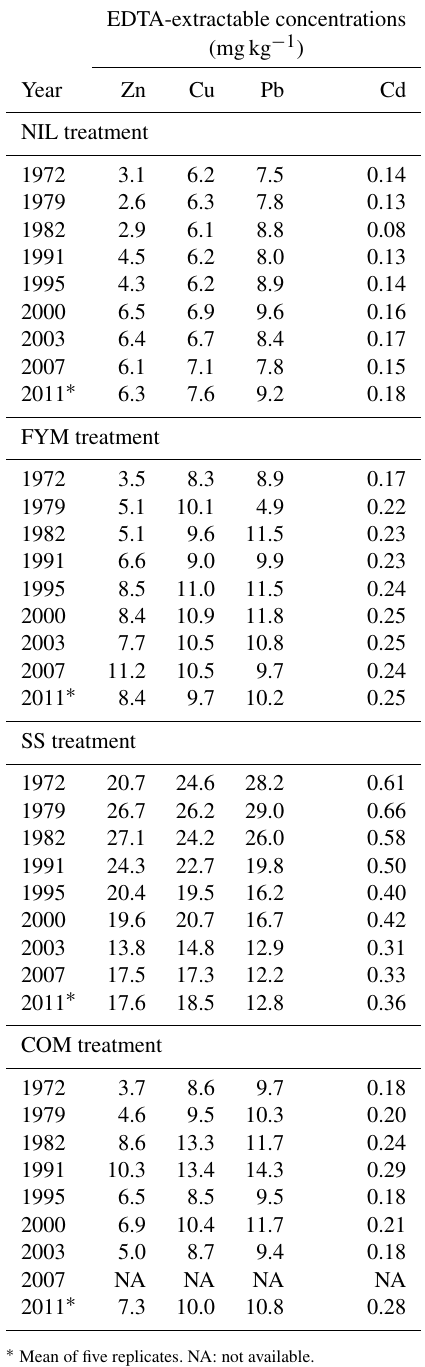
Table 1. Soil EDTA-extractable concentrations of Zn, Cu, Pb and Cd in ZOFE topsoil (0–20cm) for the treatments NIL, FYM, SS and COM.